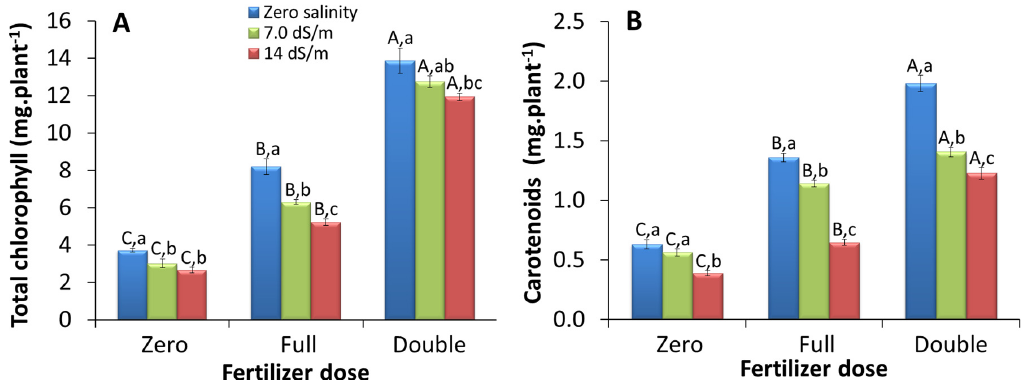
Figure 2. Actual amount of leaf pigments produced by a whole wheat plant under various treatments employed in the experiment expressed as mg ∙ Plant − 1 : ( A ) total chlorophyll and ( B ) total carotenoids content. Fertilizer treatments are grouped along the x ‐ axis and different color bars represent the salinity treatment. ANOVA was performed to test the effect of treatments of salinity and fertilizer and their interaction. The post ‐ hoc analysis was performed using Tukey’s HSD test. Statistically significant differences are presented by different letters above the bars. Different capital letters indicate significant differences among the three fertilizer doses at a given salinity level (two ‐ way ANOVA, Tukey’s test, p < 0.01). Different lowercase letters indicate significant differences among salinity treatments in each fertilizer dose (two ‐ way ANOVA, Tukey’s test, p < 0.01). Means with the same letters show non ‐ significant difference at p < 0.01. Values are means of ~30 observations with error bars as standard deviations of the mean.